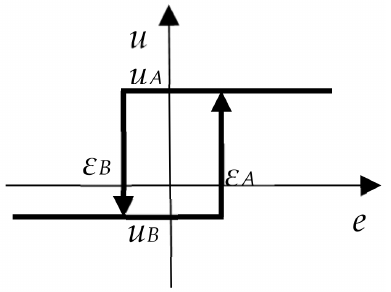
Figure 2. Static characteristics of an asymmetric relay with